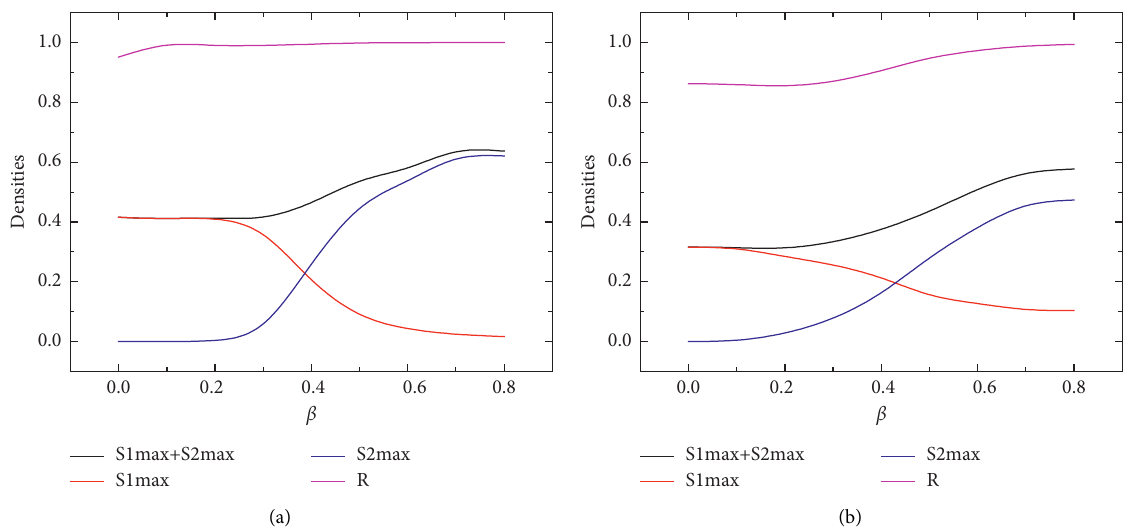
Figure 7: The influence of different values of β on rumor spreading. (a) WS small-world network. (b) BA scale-free